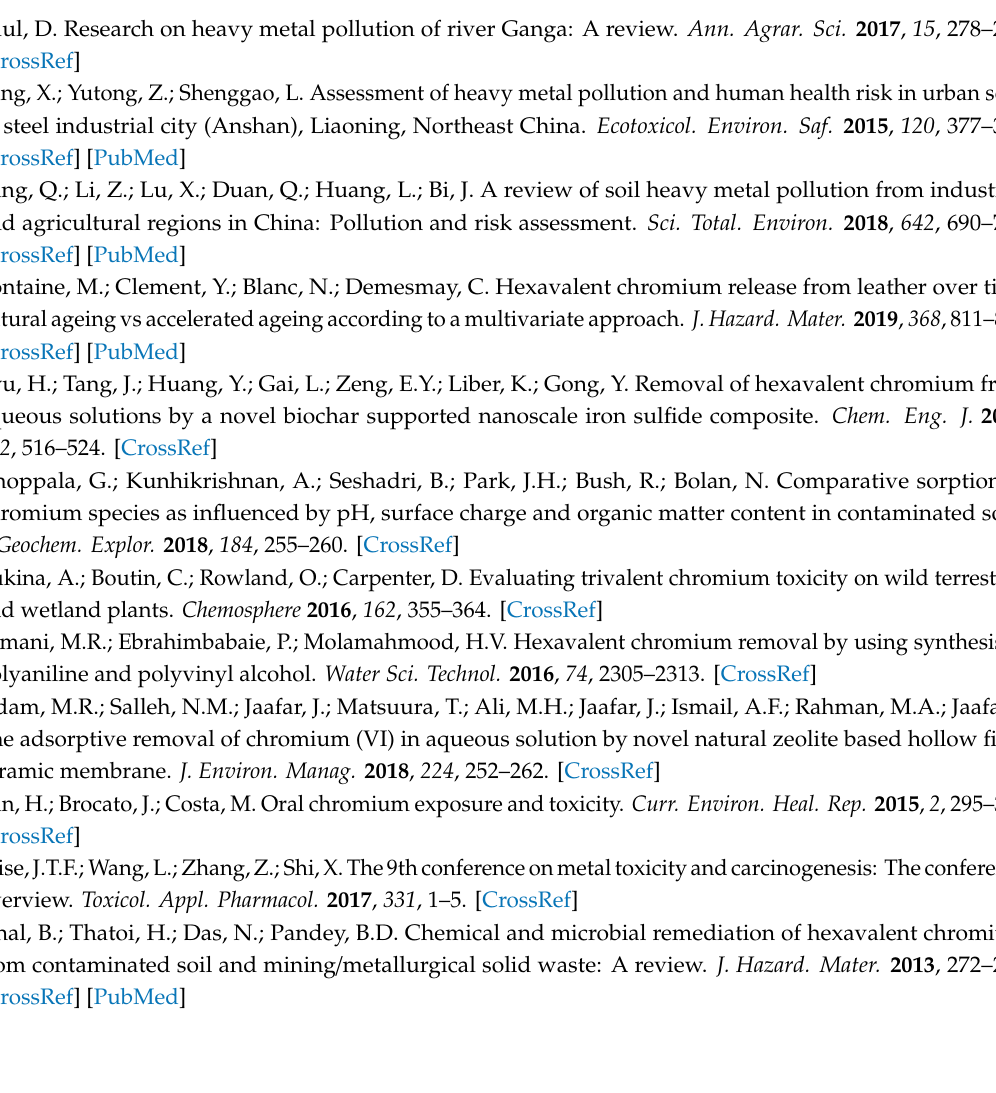
Section 1: Pretreatment of montmorillonite (MMT). Section 2: Modified European Community Bureau of tests. Section 4: Preparation of the soil extract for the Vicia faba micronucleus test. Section 5: Removal of Cr(VI) by CMC@MMT-FeS in aqueous solution. Table S1 : Physical and chemical properties of the contaminated soil samples. Table S2 : Solutions used in the modified European Community Bureau of Reference (BCR) method. Table S3 : Concentration of Cr(VI) in soil samples for the Eisenia foetida experiments. Table S4 : Fitting parameters of the kinetic model of Cr(VI) removal in aqueous solution. Figure S1: E ff ect of FeS loading on Cr(VI) removal e ffi ciency in aqueous solution. Figure S2: Total Cr in the contaminated soil before and after remediation. Figure S3: Elongation rate of Vicia faba root tips in di ff erent treatment groups. Author Contributions: Conceptualization D.Z. (Dexun Zou) Data curation X.L., L.W. Formal analysis X.H. Project administration Y.M., D.Z.(Dexun Zou). Resources Y.M. Supervision C.L., Y.M. Visualization Z.L. Writing—original draft D.Z. (Dading Zhang), Y.X. Writing—review & editing D.Z. (Dading Zhang), Y.X., Y.M., D.Z. (Dexun